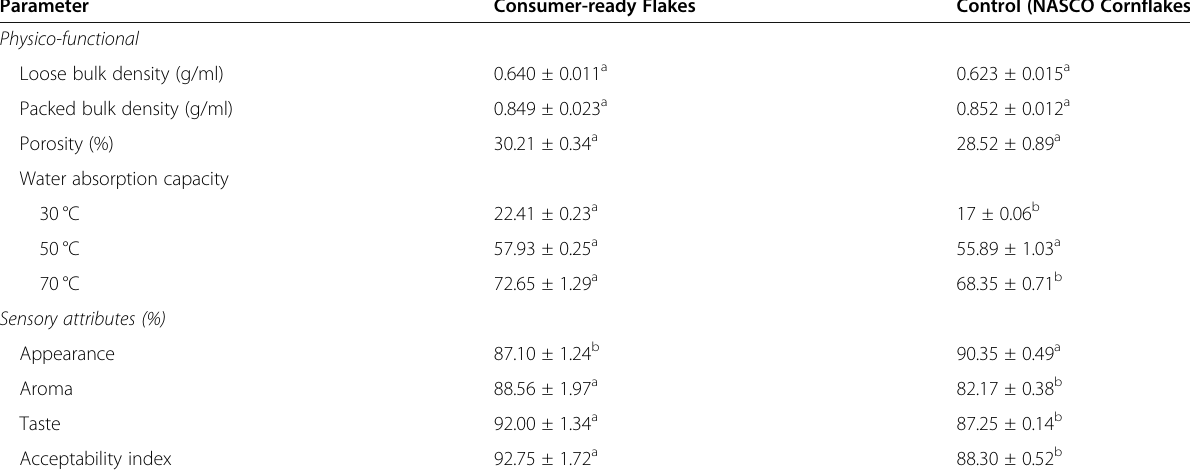
Table 5 Physico-functional and sensory characteristics of consumer-ready flakes from high-protein soymeal, amaranth and modified corn starch produced under optimal